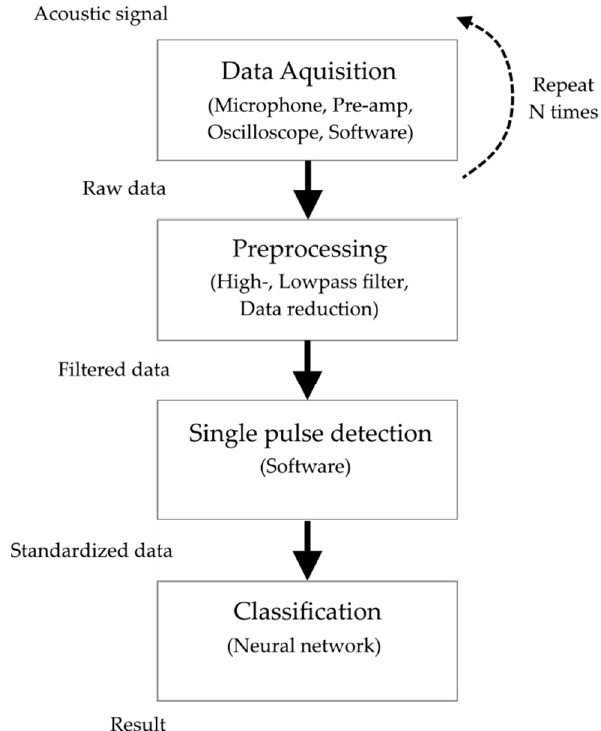
Figure 2. Flow chart of signal processing for the classification of the laser-acoustic material response.